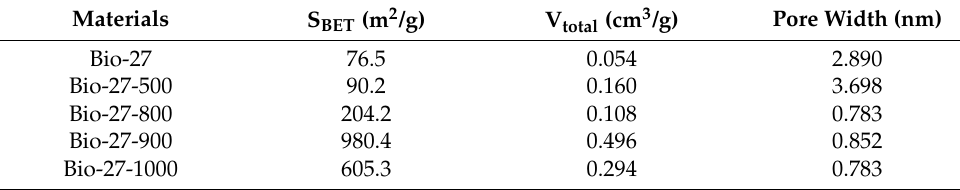
Table 2. Calculated surface area (S BET ) and porous